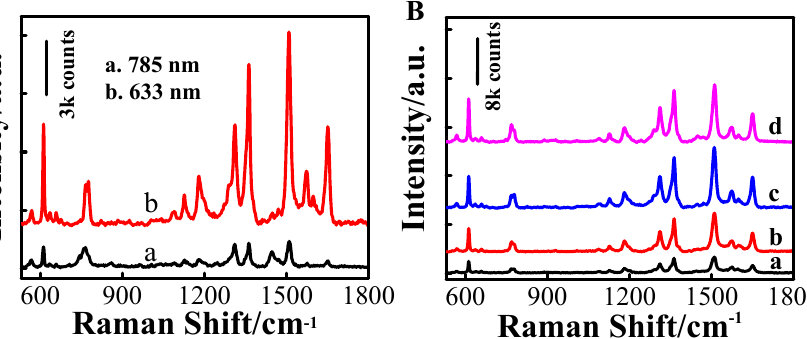
Figure 2. ( A ) The comparison of Raman signals collected under different laser light sources with wavelengths of 785 nm and 633 nm, respectively; ( B ) SERS spectra of 0.10 µ M R6G on Au NRs@TiO 2 SERS substrates with different amounts of Au NRs@TiO 2 . The dilution factors of Au NRs@TiO 2 in a-d were 32 (a), 16 (b), 12 (c), 4 (d) times, respectively, as compared with the synthesized Au NRs@TiO 2 solution.